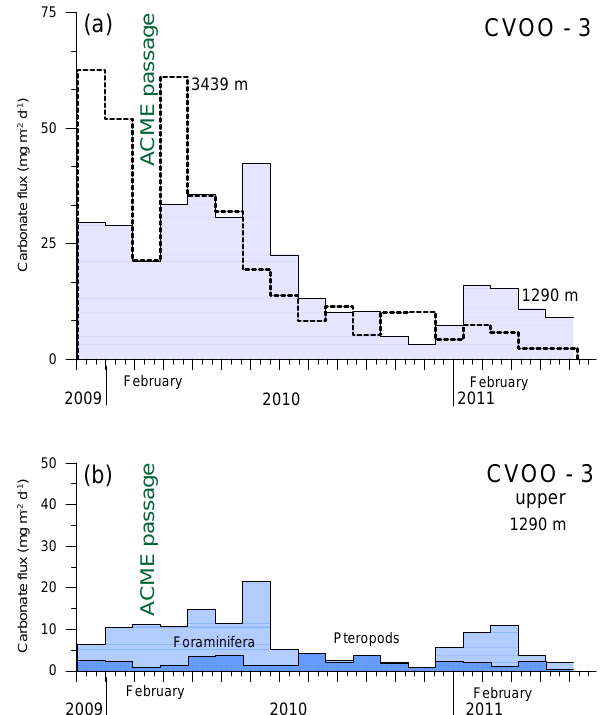
Figure 7. Carbonate fluxes collected with the upper and lower sed- iment trap (a) at CVOO-3 shown together with fluxes of planktonic foraminifera and pteropods (only upper trap data, (b) , Table 2). Cor- relation of fluxes between both depths is less significant here com- pared to the other bulk components ( r 2 = 0.5, n = 20). Note that total carbonate fluxes decreased during eddy passage in February